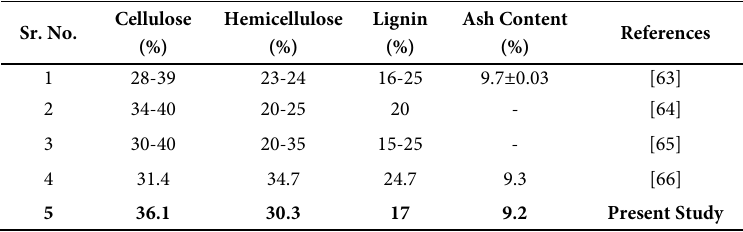
Table.2. Composition of Wheat